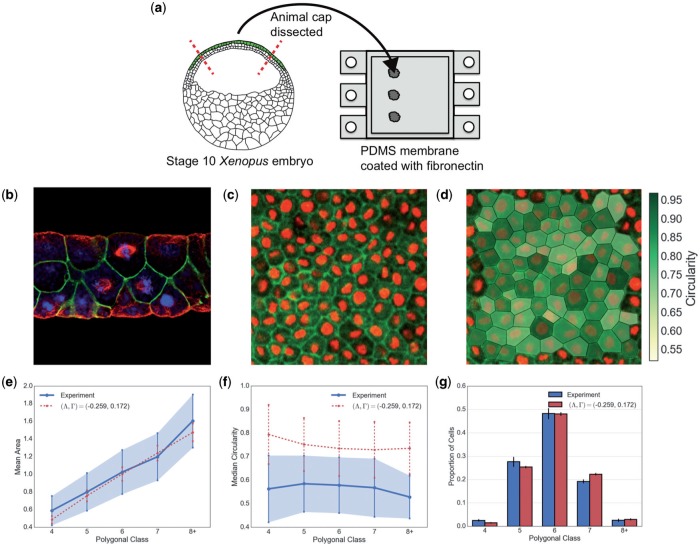
Experimental setup and data analysis. (a) Animal cap tissue was dissected from stage-10 Xenopus laevis embryos and cultured on PDMS membrane. (b) Side-view confocal image of the animal cap (top:apical; bottom:basal), stained for microtubules (red), beta-catenin (green) and DNA (blue). A mitotic spindle is visible in the centremost apical cell. The animal cap is a multi-layered epithelial tissue; we analyse just the outer, apical, cell layer. (c) The apical cell layer of the animal cap tissue is imaged live using confocal microscopy (green, GFP-\documentclass[12pt]{minimal}
\usepackage{amsmath}
\usepackage{wasysym} 
\usepackage{amsfonts} 
\usepackage{amssymb} 
\usepackage{amsbsy}
\usepackage{upgreek}
\usepackage{mathrsfs}
\setlength{\oddsidemargin}{-69pt}
\begin{document}
}{}$\alpha$\end{document}-tubulin; red, cherry-histone2B). (d) The cell edges are manually traced and cell shapes are derived computationally, being polygonized using the positions of cell junctions. (e) Mean normalized area as a function of polygonal class showing mean and one standard deviation, from experiments (solid and shaded) and simulation (dashed) with parameters \documentclass[12pt]{minimal}
\usepackage{amsmath}
\usepackage{wasysym} 
\usepackage{amsfonts} 
\usepackage{amssymb} 
\usepackage{amsbsy}
\usepackage{upgreek}
\usepackage{mathrsfs}
\setlength{\oddsidemargin}{-69pt}
\begin{document}
}{}$\Lambda$\end{document}, \documentclass[12pt]{minimal}
\usepackage{amsmath}
\usepackage{wasysym} 
\usepackage{amsfonts} 
\usepackage{amssymb} 
\usepackage{amsbsy}
\usepackage{upgreek}
\usepackage{mathrsfs}
\setlength{\oddsidemargin}{-69pt}
\begin{document}
}{}$\Gamma$\end{document} as shown with \documentclass[12pt]{minimal}
\usepackage{amsmath}
\usepackage{wasysym} 
\usepackage{amsfonts} 
\usepackage{amssymb} 
\usepackage{amsbsy}
\usepackage{upgreek}
\usepackage{mathrsfs}
\setlength{\oddsidemargin}{-69pt}
\begin{document}
}{}$P_{\mathrm{ext}}=0$\end{document}. Cell areas were normalized relative to the mean of each experiment. (f) Circularity as a function of polygonal class showing mean and one standard deviation, from experiments (solid and shaded) and simulation (dashed) using the same parameters as in (e). (g) Proportions of total cells in each polygonal class in experiments (left bar) and simulations (right bar). Error bars represent \documentclass[12pt]{minimal}
\usepackage{amsmath}
\usepackage{wasysym} 
\usepackage{amsfonts} 
\usepackage{amssymb} 
\usepackage{amsbsy}
\usepackage{upgreek}
\usepackage{mathrsfs}
\setlength{\oddsidemargin}{-69pt}
\begin{document}
}{}$95\%$\end{document} confidence intervals calculated from bootstrapping the data. (Colour in online.)